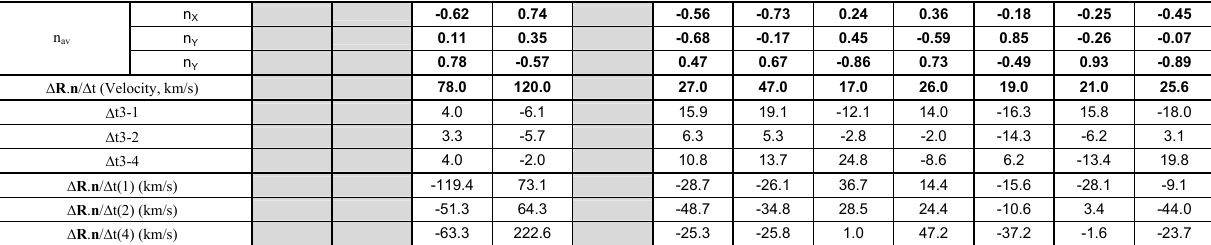
Table 1. Results from PTA and DA. Columns indicate the boundary number from Fig. 1. Boundary 1a is described in the text. The upper section of the table shows the times of the boundary observation at each spacecraft. Below this are the results of the PTA: the components of the normal and the speed of the boundary. Below this are the percentage errors in each normal component followed by the correlation coefficients of the boundary at each spacecraft with spacecraft 3. The lower table shows the DA results. The first 3 rows show the “average” normal direction, followed by the speed of this normal. Below this are 3 inter-spacecraft time differences of the boundary, i.e. 1 t3–1 is the time taken for the boundary to have traveled from spacecraft 1 to 3. Finally, the final three rows show the speed variations along the normal direction, all with respect to spacecraft 3, i.e. 1 R.n / 1 t Eq. (1) km/s is the boundary speed between Cluster 3 and 1. Note, DA times are not shown but are as close to the PTA boundary times as the data allowed, again this is discussed in the text.